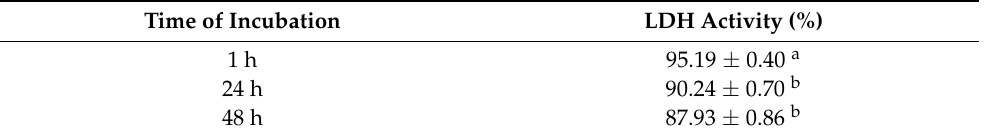
Table 1. Measurement of lactate dehydrogenase (LDH) activity in equine endometrial explants after 1, 24, or 48 h incubation. Results are presented as the mean ± SEM. Different superscript letters indicate statistical differences within the time of incubation ( a,b : p < 0.05).